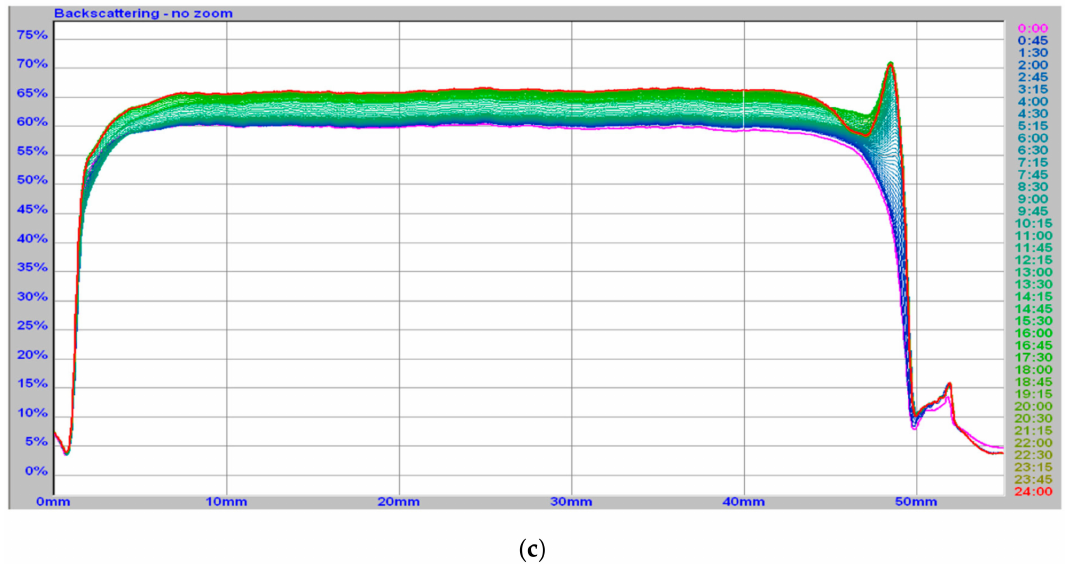
Figure 2. Evolution of backscattering spectra during curd coagulation for milk with rennet ( a ), milk with rennet and fermented juice ( b ) and milk with fermented curly kale juice ( c )